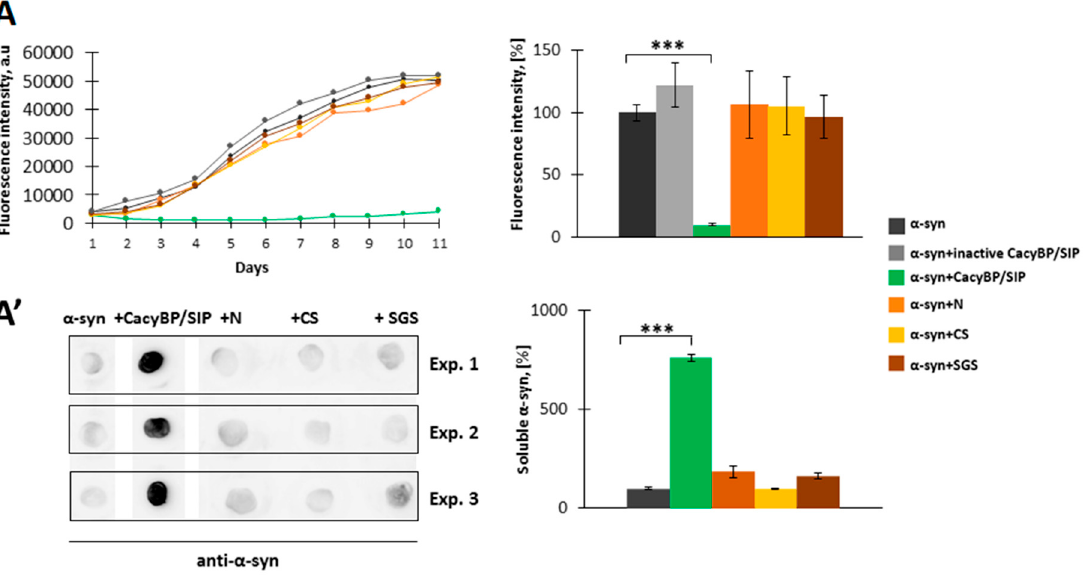
Figure 5. Influence of CacyBP/SIP domains on α -synuclein aggregation. ( A, left panel ) Representative curves showing ThT fluorescence of 30 µM α -synuclein alone (black) or in the presence of 30 µM: inactive CacyBP/SIP (grey), CacyBP/SIP (green), N domain (orange), CS domain (yellow) or SGS domain (brown). ( A, right panel ) Statistical analysis of the results ( n = 3). ( A’, left panel ) Dot-blots showing α -synuclein immunostaining in the soluble fraction and ( A’, right panel ) statistical analysis of the results ( n = 3). (B, left panel) Representative curves showing ThT fluorescence of 30 µM α -synuclein alone (black) or in the presence of 30 µM: inactive CacyBP/SIP (grey), CacyBP/SIP (green) or NCS fragment of CacyBP/SIP (violet) ( B, right panel ) Statistical analysis of the results ( n = 3). ( B’, left panel ) Dot-blots showing α -synuclein immunostaining in the soluble fraction and ( B’, right panel ) statistical analysis of the results ( n = 3). In all cases, samples were taken on day 4 of incubation and data, calculated as means ± SEM, are presented as percentage values. ** p ≤ 0.01, *** p ≤ 0.001.